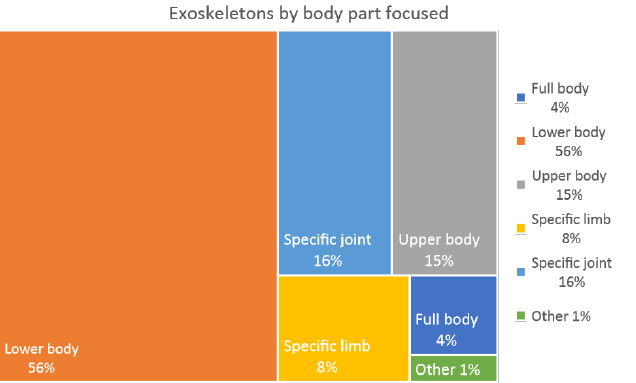
Figure 6. Chart of the classification of exoskeletons by the body parts on which the exoskeletons are